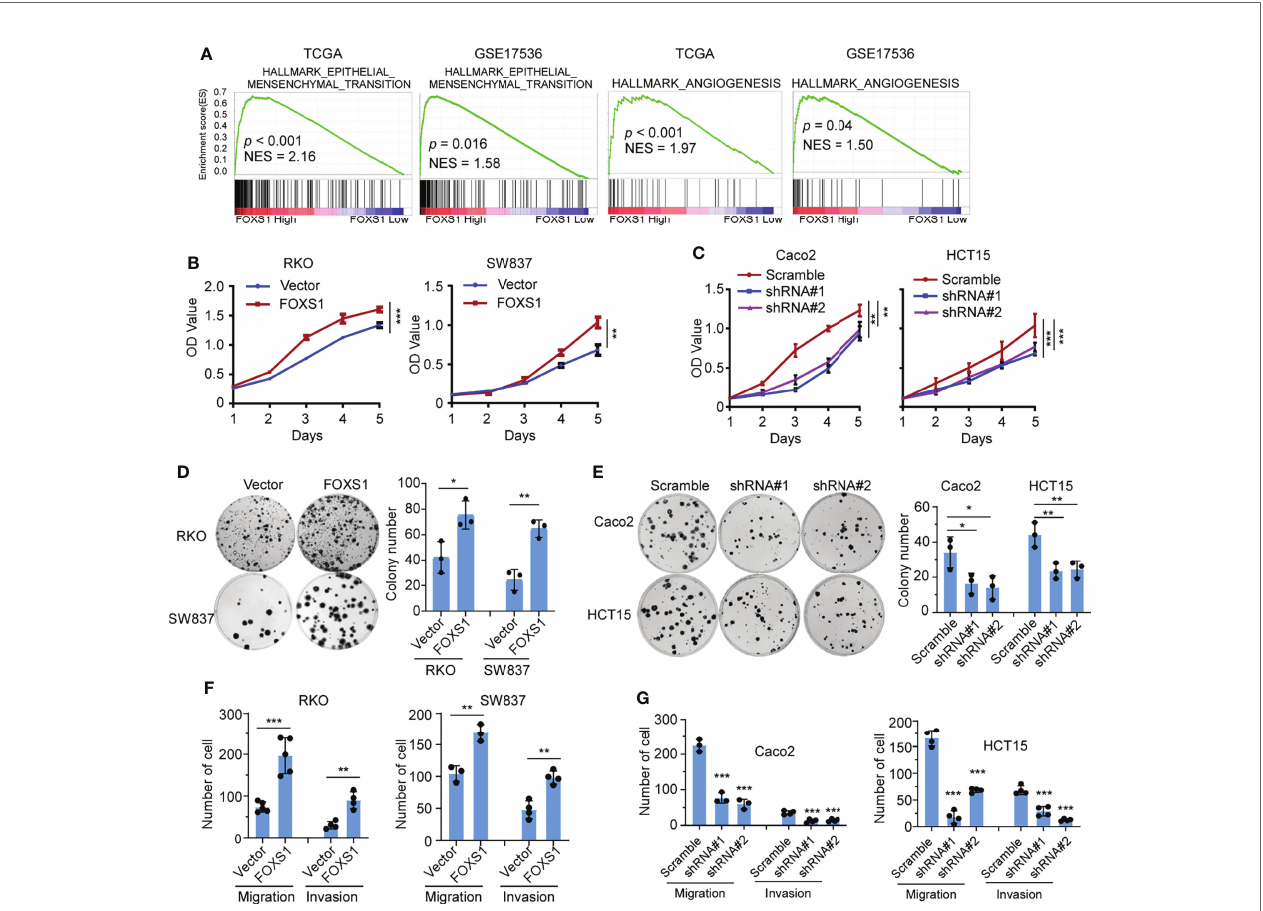
FIGURE 2 | FOXS1 promotes proliferation and invasiveness of CRC cells in vitro. (A) GSEAs in TCGA-CRC and GSE17536 datasets. (B, C) MTT assays were performed to determine the effects of FOXS1 overexpression (B) or FOXS1 knockdown (C) on the proliferation of CRC cells. (D, E) Colony-formation assays were performed to determine the growth of FOXS1-overexpressed (D) or FOXS1-knockdown CRC cells (E) . (F, G) Transwell migration assay and invasion assay were performed to evaluate the migratory and invasive abilities of FOXS1-overexpressed (F) or FOXS1-knockdown CRC cells in vitro (G) . * p < 0.05, ** p < 0.01, *** p <